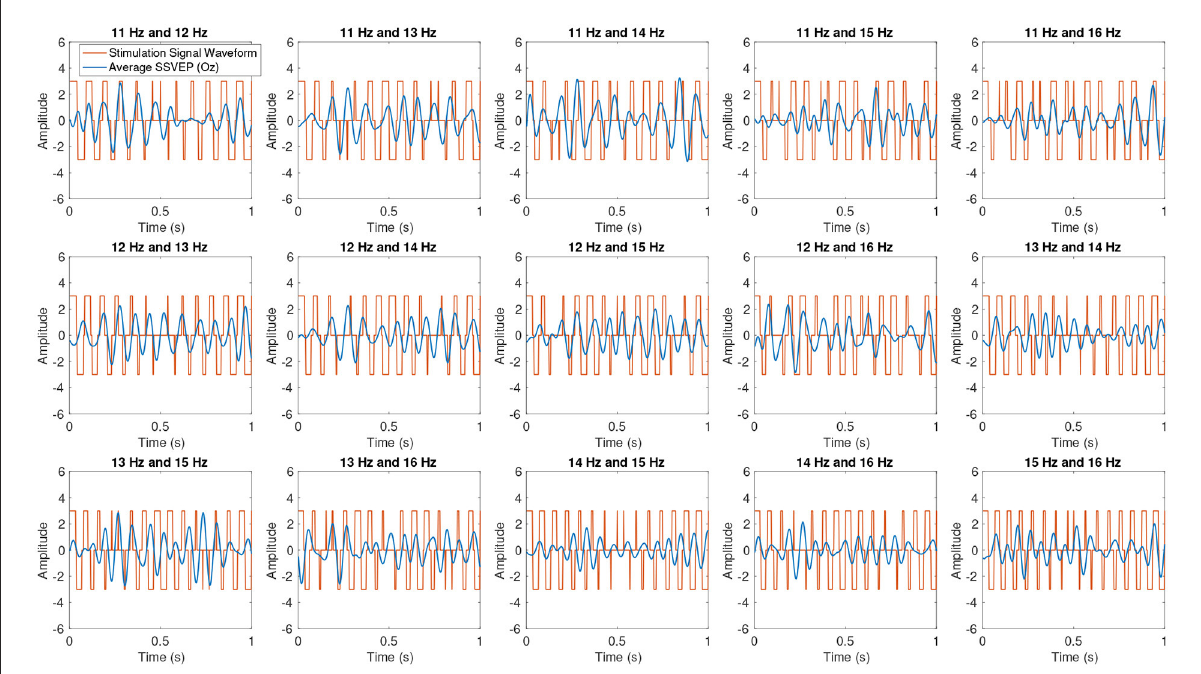
FIGURE4 Average SSVEP from Test 1 in time domain. Blue lines plot the average SSVEPs from channel Oz after bandpass filtered between 9 and 18 Hz. Orange lines show the waveforms of the dual-frequency stimulation